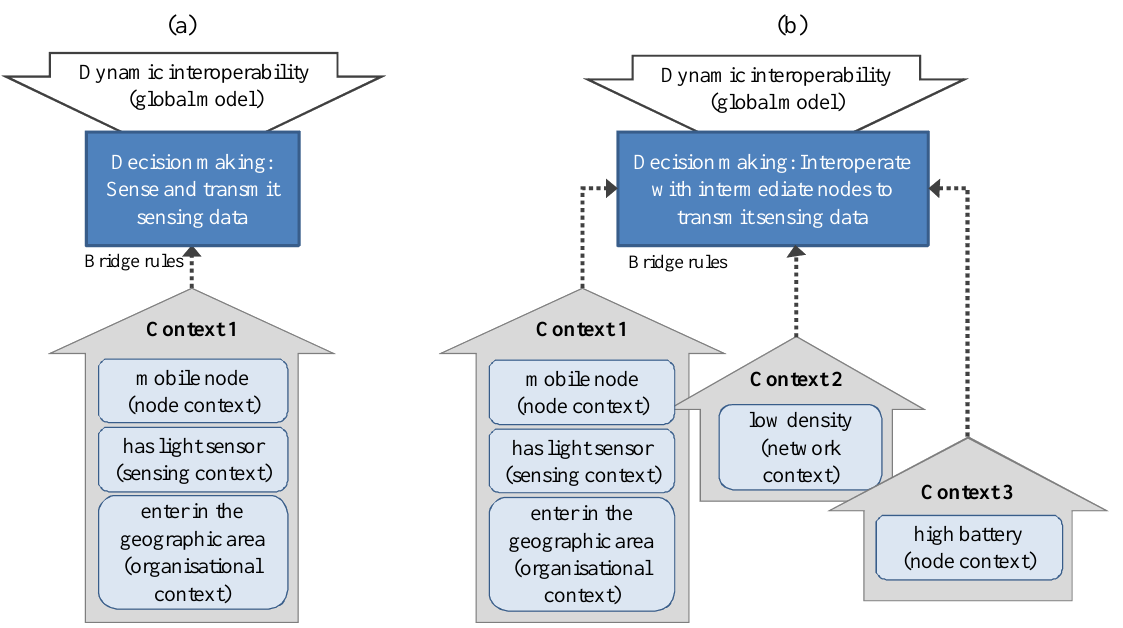
Figure 4. (a) Bridge rules evaluating local contexts. (b) Bridge rules linking and evaluating multiple